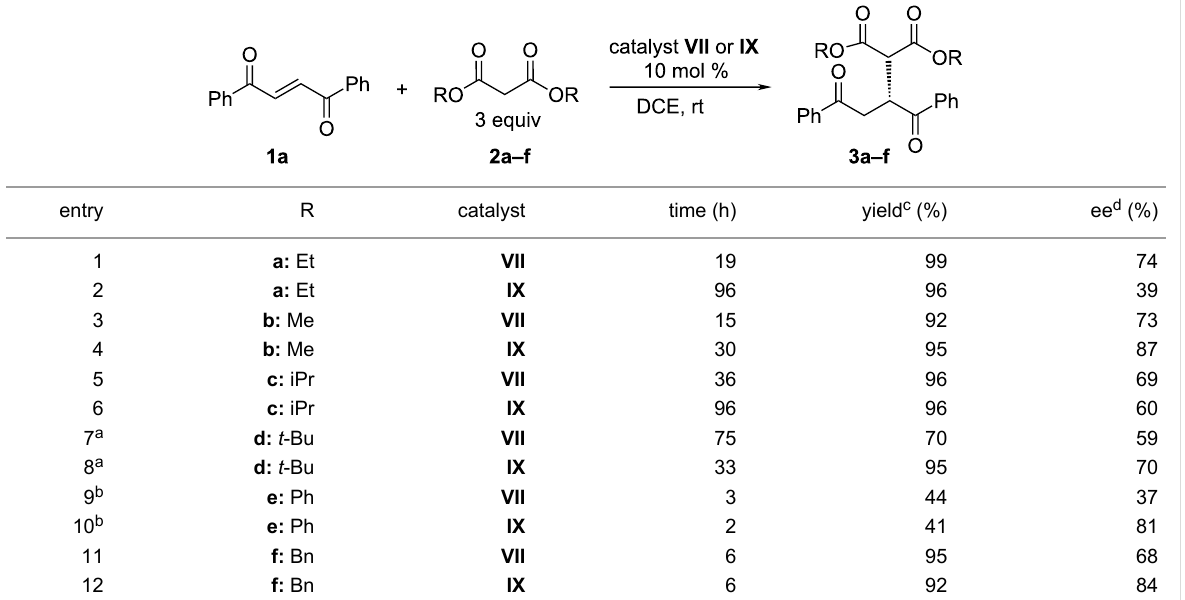
Table 3: Enantioselective addition of diethylmalonate 2a to substituted 1,4-diketones 1a, g–j .